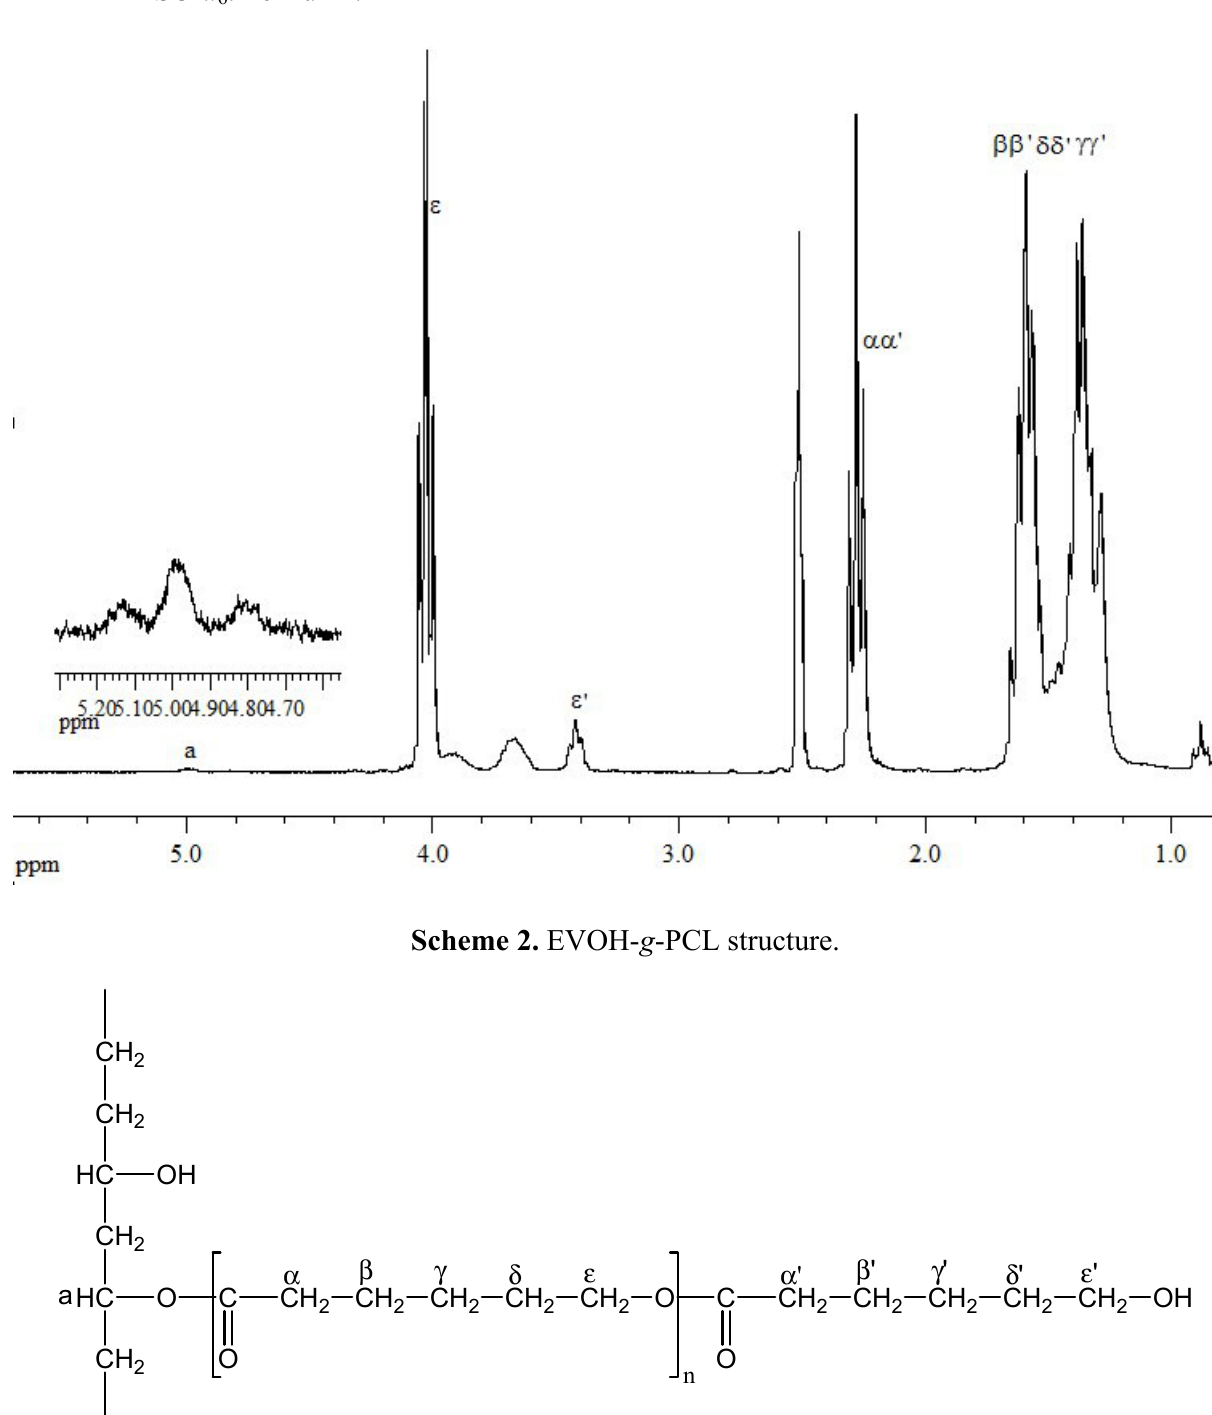
Figure 4. 1 H NMR spectrum obtained for EVOH- g -PCL synthesis by adding ε -caprolactone in DMSO- d . For run 6